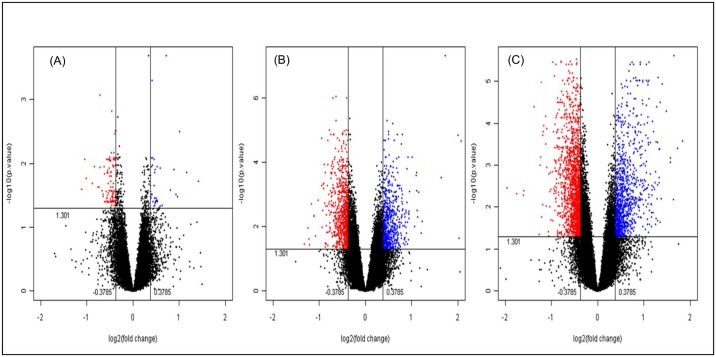
Volcano plots representing the differentially expressed genes (up and down-regulated) at 1.3 fold in different HLNRA groups (Group II, III and IV) as compared to NLNRA (Group I).A) Group I vs. II, B) Group I vs. III, C) Group I vs. IV. Blue dots represent significant (p<0.05) up-regulated genes and red dots represent significant down- regulated genes.